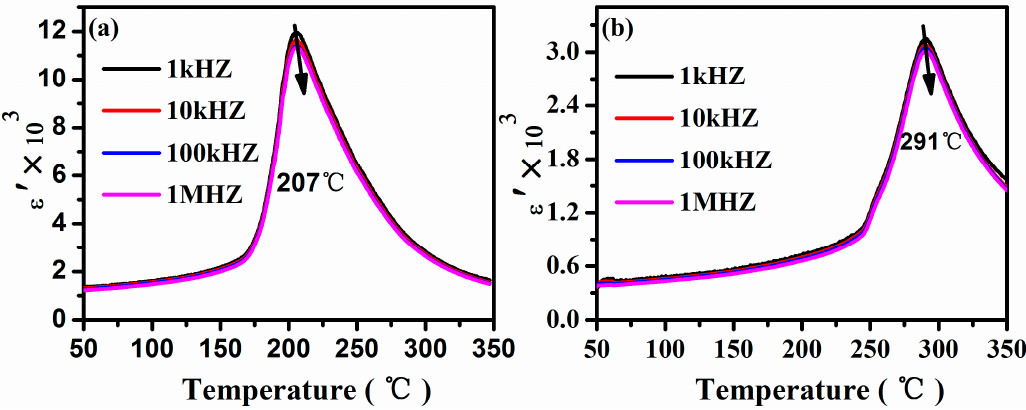
Figure 4. Temperature dependence of dielectric permittivity ε ’ for [100]-oriented PEN-PMN-PT: ( a ) 20PEN-40PMN-40PT; ( b ) 40PEN-13PMN-47PT. Polarization versus electric field ( P - E ) of [100]-oriented PEN-PMN-PT crystals with 28 kV/cm at